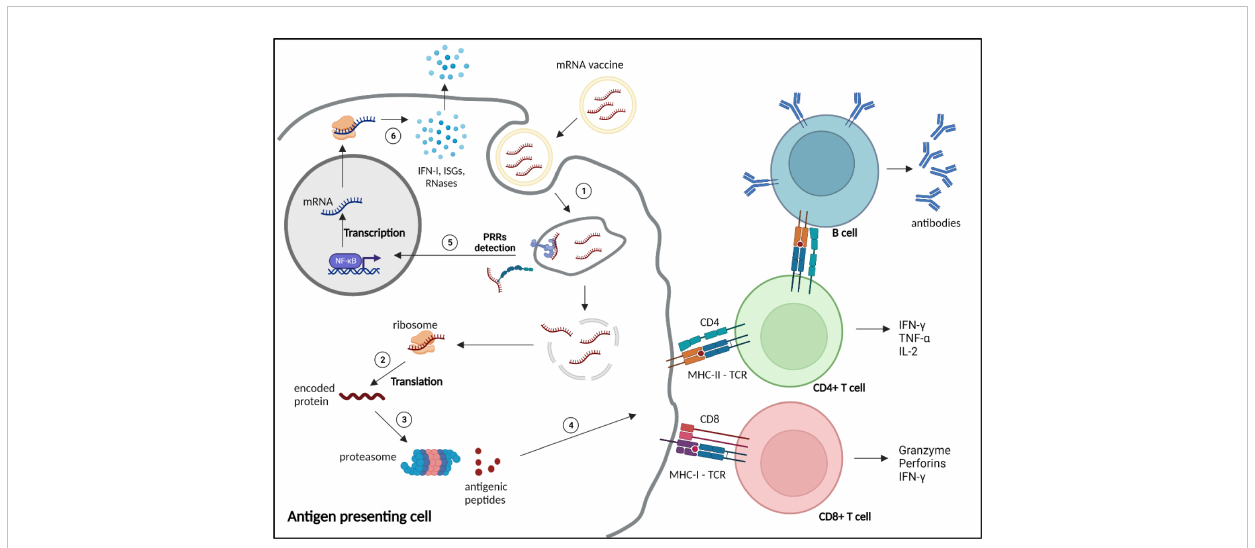
FIGURE 2 Mechanism of action and immune response induced by mRNA vaccines. 1) mRNA vaccines enter the cells through different mechanisms depending on the nature and size of the nanoparticles, such as clathrin-, caveolin- and receptor-mediated endocytosis, micropinocytosis, phagocytosis or diffusion across the cell membrane (47). 2) After reaching the cytoplasm, mRNAs are translated by the ribosomes into the encoded protein. 3) The protein is processed by the proteasome into small antigenic peptides. 4) The peptides are presented at the surface of the antigen presenting cell by major histocompatibility complex (MHC) molecules to prime CD4+ and CD8+ T cells through, respectively, MHC-II or MHC-I interaction with the T cell receptor (TCR), to activate humoral and cellular adaptive responses. 5) Exogenous mRNAs can be detected by the innate immune system through binding to pattern recognition receptors (PRRs) localised at the endosomal membrane or in the cytosol, inducing the transcription and translation (6) of proin fl ammatory factors, such as type 1 interferons (IFN-I), IFN-stimulated genes (ISGs) and RNases. NF- k B, nuclear factor k B. Created with